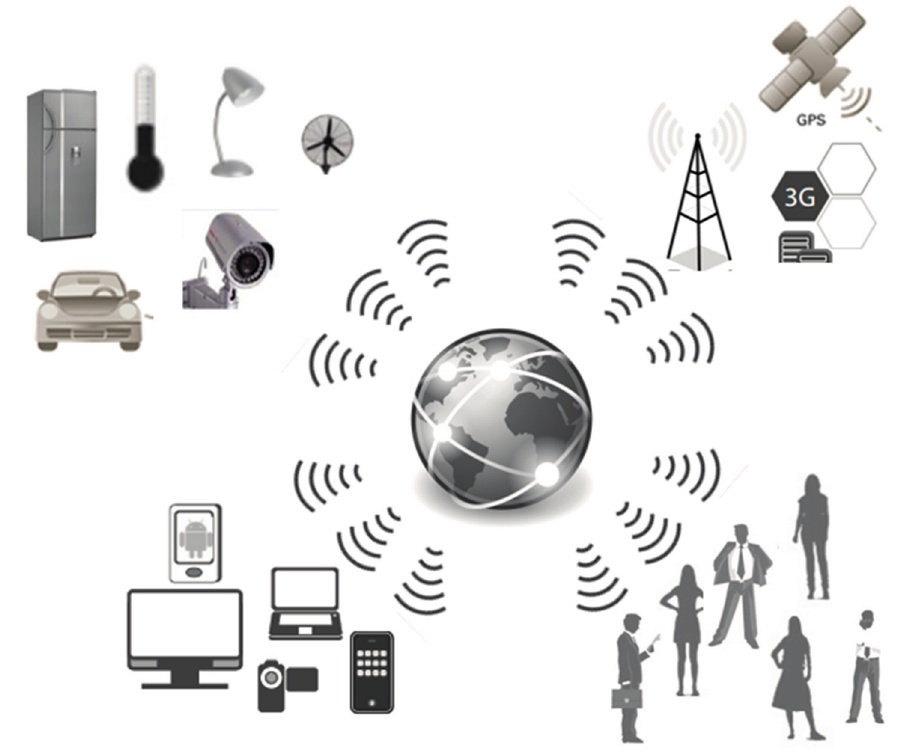
Figure 1. Internet of Things